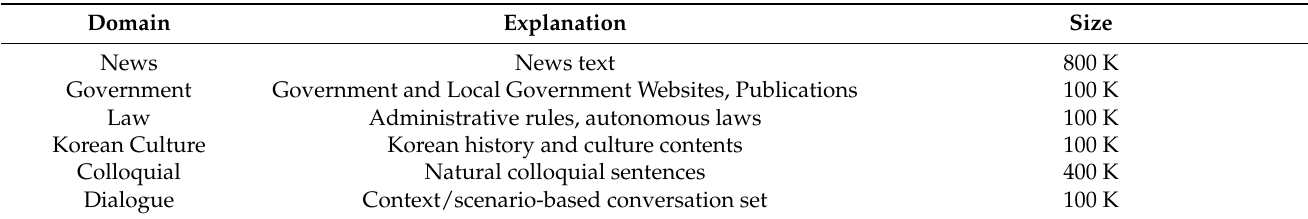
Table 7. Statistics and Elements of the Dataset Used.